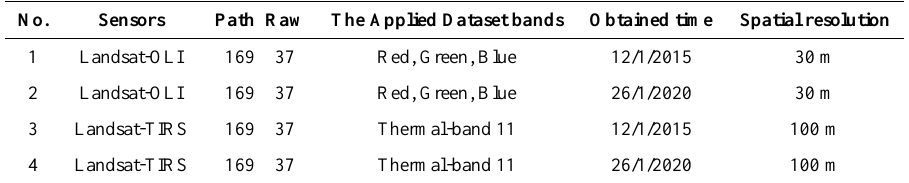
Table 1. The specifications of the Landsat-8 of OLI and TIRS datasets